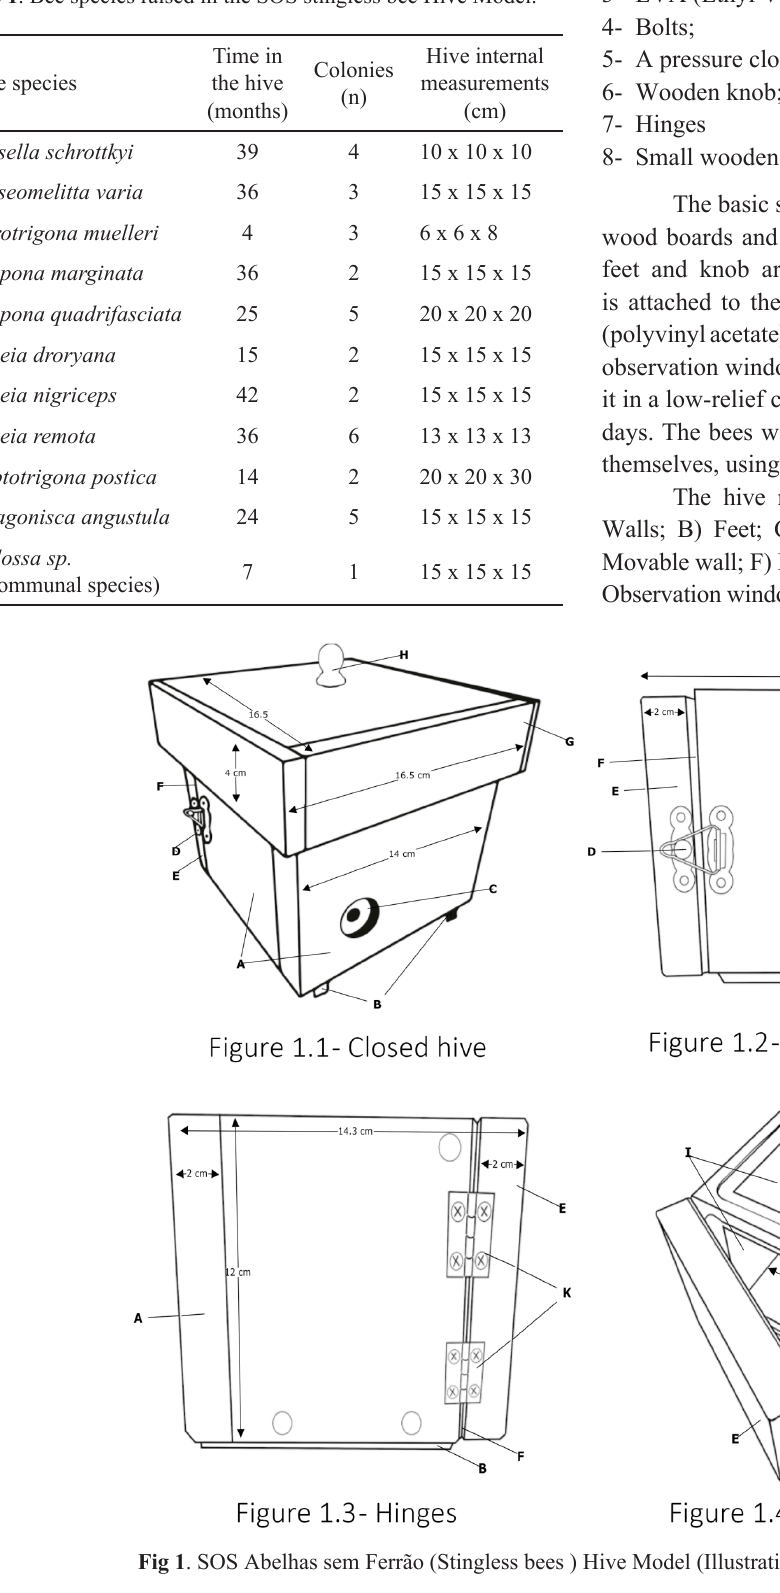
Table 1 . Bee species raised in the SOS stingless bee Hive Model.